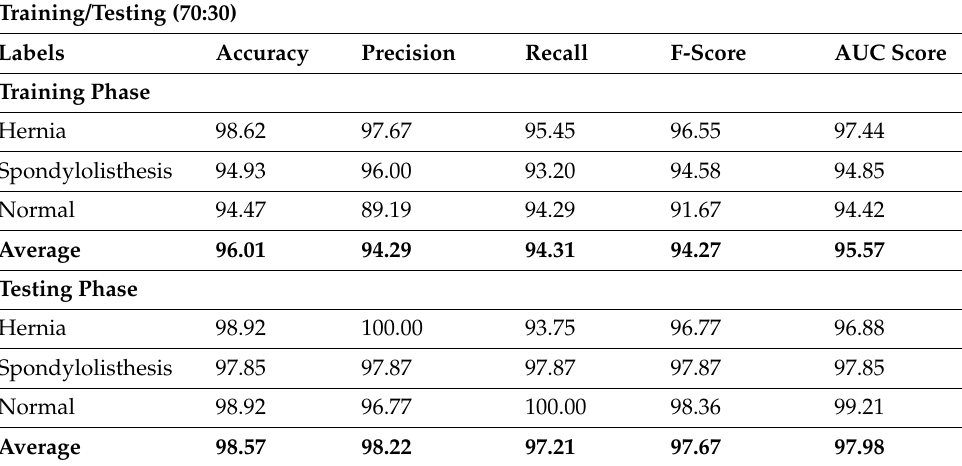
Table 3. RA Classification results of ARAC-AOADL model on 70:30 of TR/TS